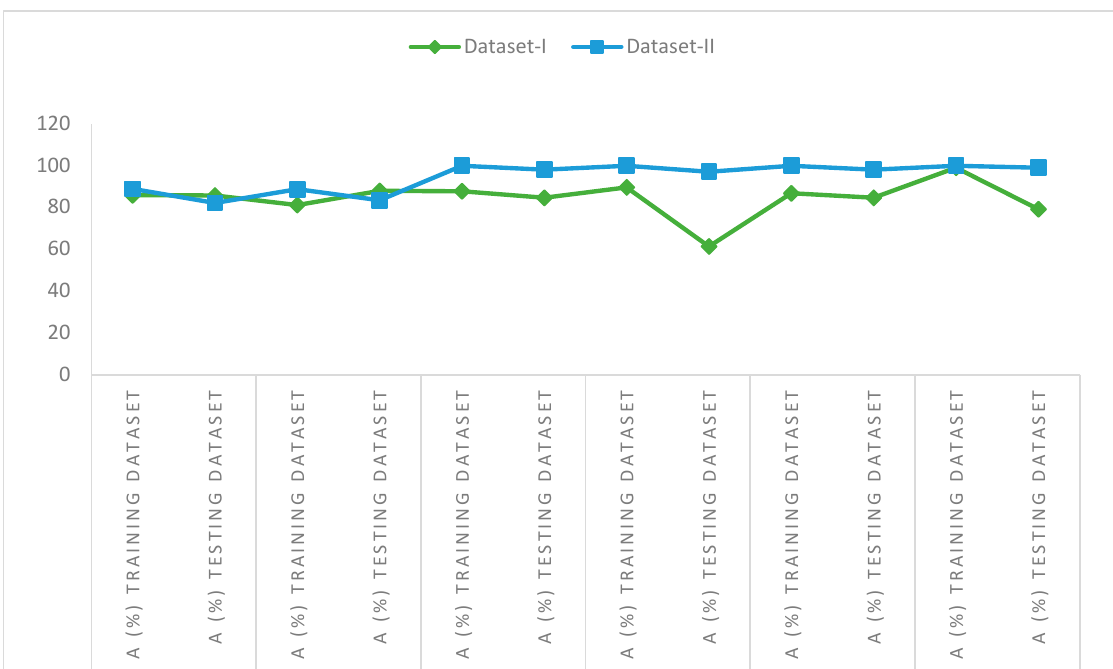
Figure 12. Comparison of the system performance regarding the diagnostic accuracies when using the two datasets.